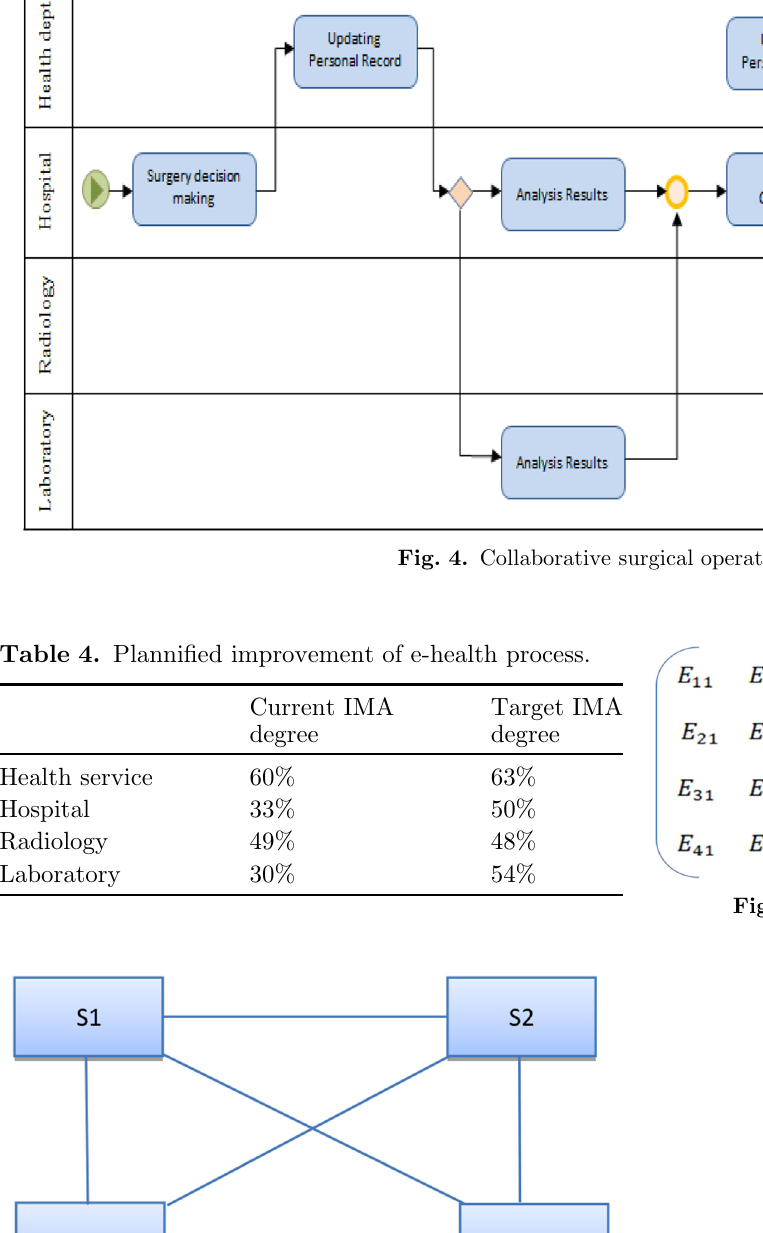
Fig. 7. Optimal efforts distribution (via